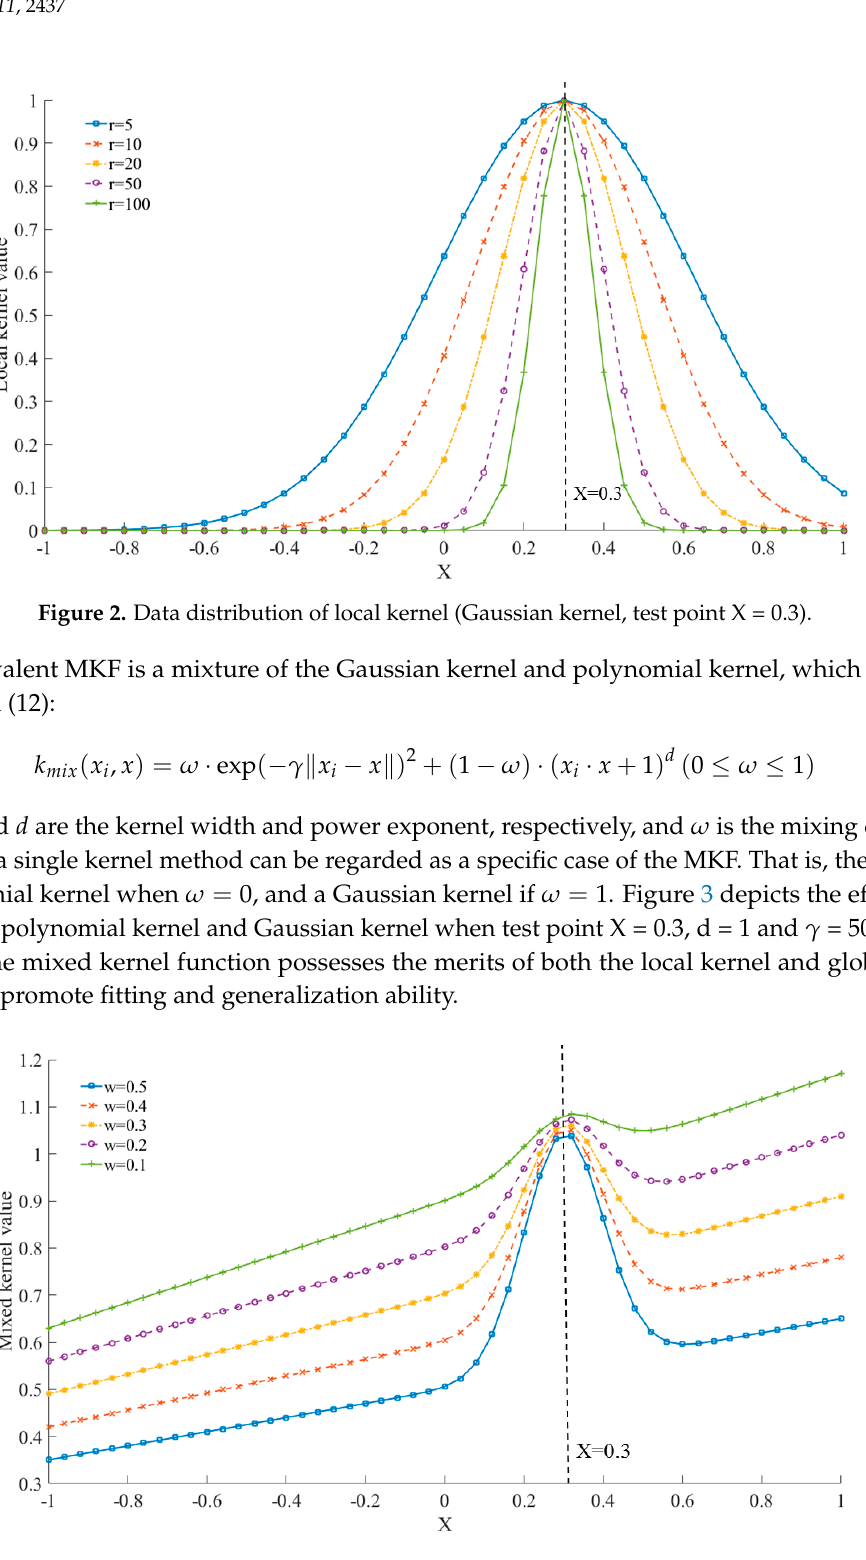
Figure 3. Data distribution of a mixed kernel (Gaussian kernel & polynomial kernel, test point X = 0.3).